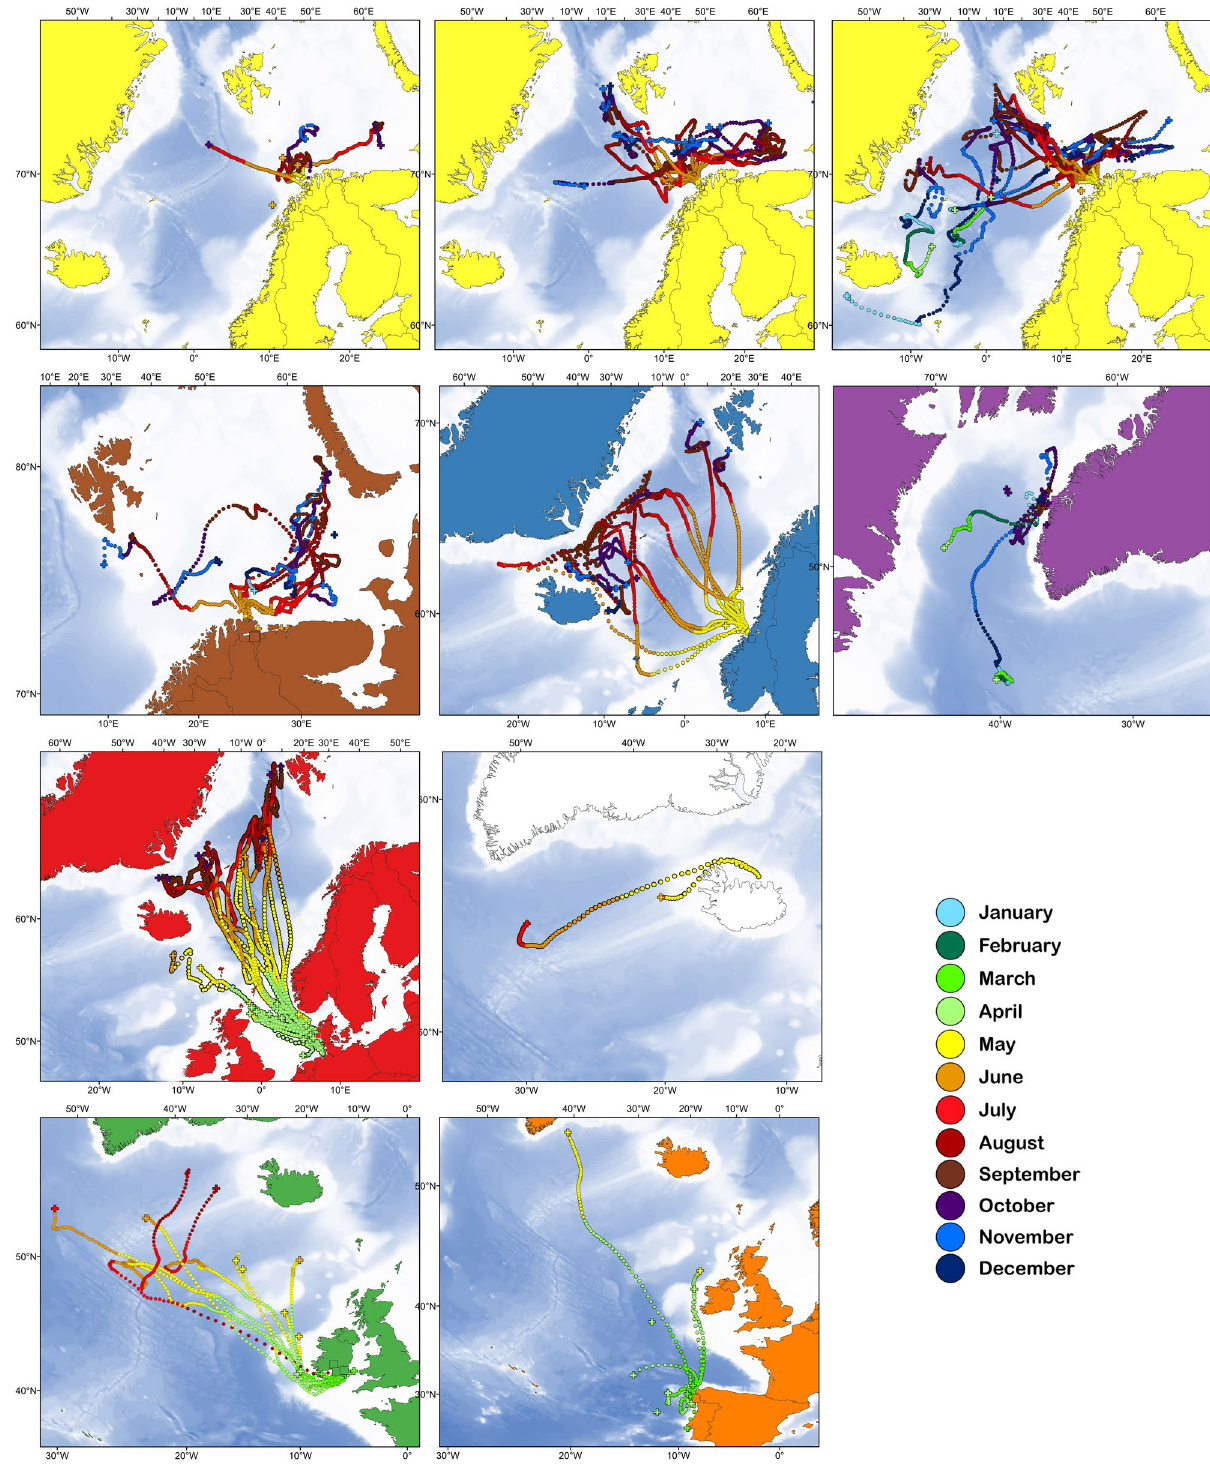
Figure 2. Migration tracks by month of individual Atlantic salmon tagged in seven geographic areas. Each panel shows the tracks of fish tagged in one geographic area (indicated by the color of the land masses in each map, corresponding to color codes in Fig. 1). Because of the large number of individuals tagged in the NW Norwegian population, the three uppermost panels show data from this population the three different years of tagging (2008–2010 left to right). Darker blue shading in the ocean indicates increasing depth as per the GEBCO bathymetry 44 . Annual data for the remaining population with multiple years of tagging is shown in Supplementary Figure S1. Maps were drawn using ESRI ArcGIS Desktop